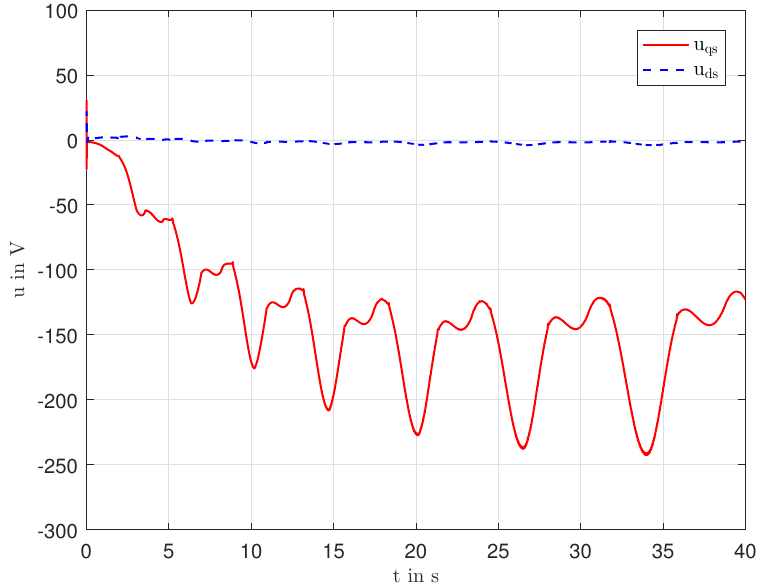
Figure 11. Two-phase control voltages of the